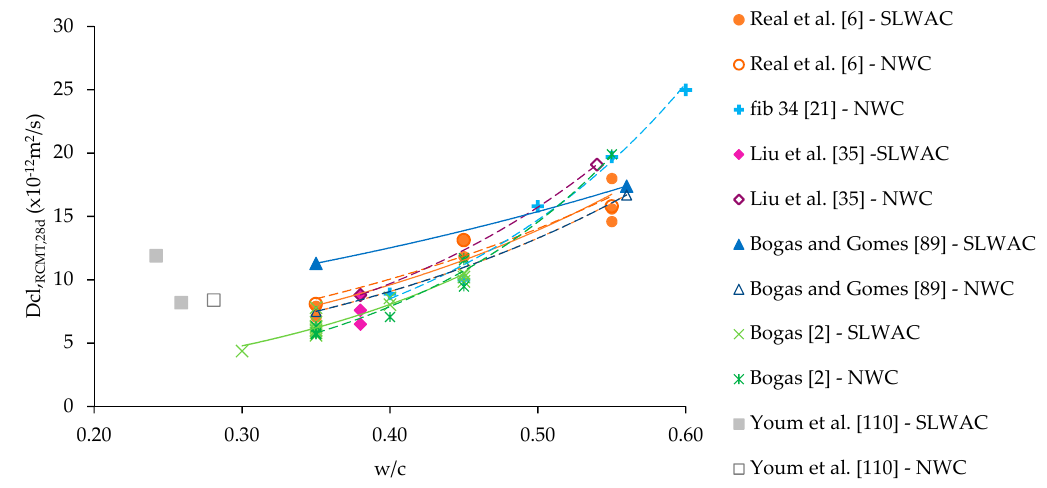
Figure 8. Chloride migration coefficient as a function of the w/c, according to various authors [2,6,21,35,89,110] .